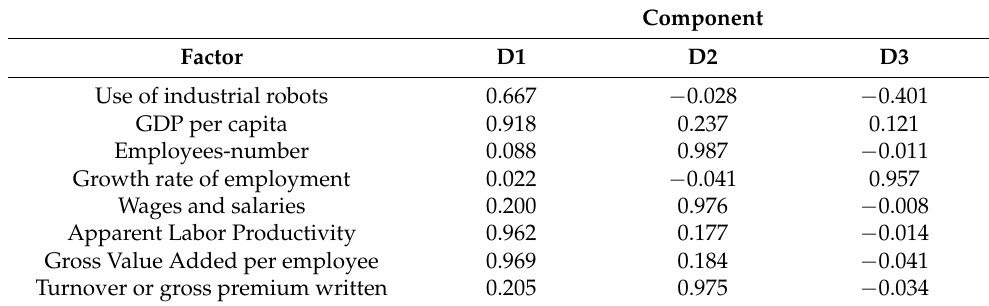
Table 3. Factor matrix after Varimax rotation. Source: Author’s contribution based on data retrieved from Eurostat. Annual enterprise statistics for special aggregates of activities.